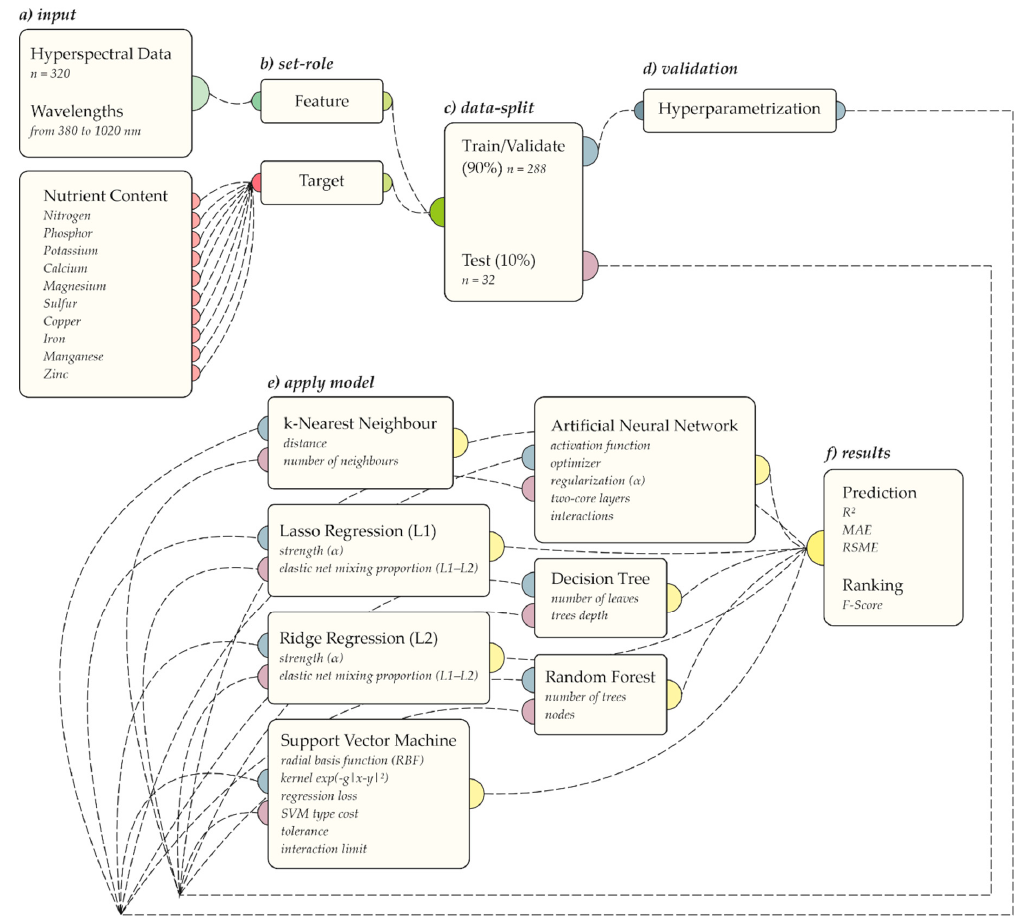
Figure 3. Structure of the machine learning architecture of the proposed framework.